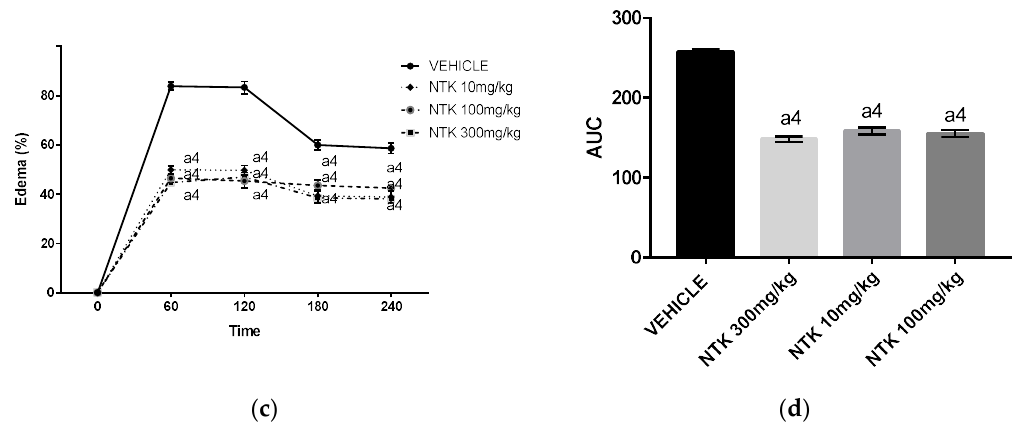
Figure 2. Time-point analysis of treatment with different NTK doses on paw edema formation induced by carrageenan ( a ) or dextran ( c ). These data are also represented as area under the curve (AUC) ( b and d , respectively). a4 = p < 0.0001 vs. saline; b3 = p < 0.001 vs. NTK 100 mg/kg group; c4 = p < 0.0001 vs. NTK 10 mg/kg group. Statistical significance was determined with two-way ANOVA (a and c) and post hoc Tukey test.